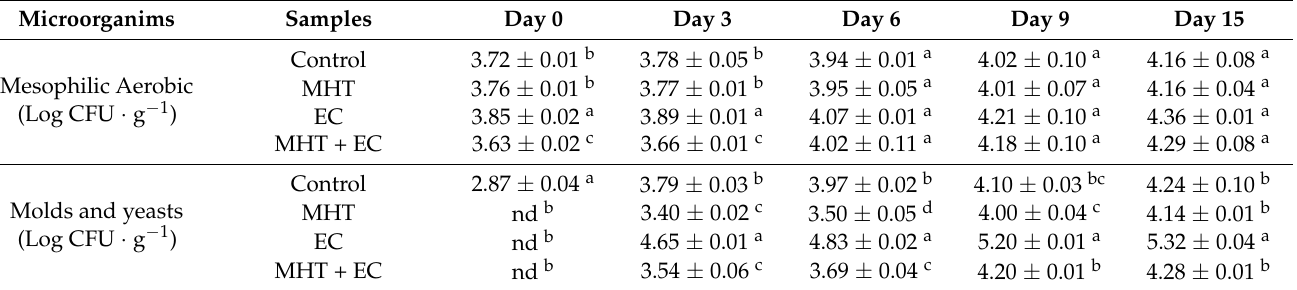
Table 1. Behavior of the mesophilic aerobic and molds/yeasts grown on control and treated minimally processed bunching green onion during storage.